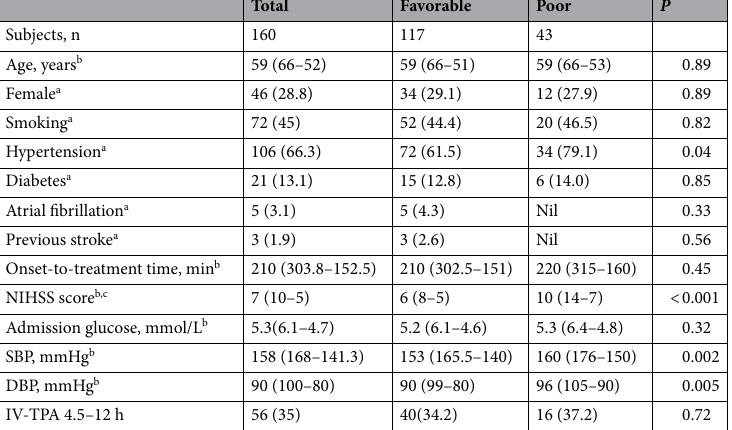
Table 1. Proportion of hypertension (61.5%, P = 0.04), baseline NIHSS score (median 6, P < 0.001), and admis- sion systolic/diastolic blood pressure (S/DBP; median 153/90 mmHg, P = 0.002, 0.005) were significantly lower